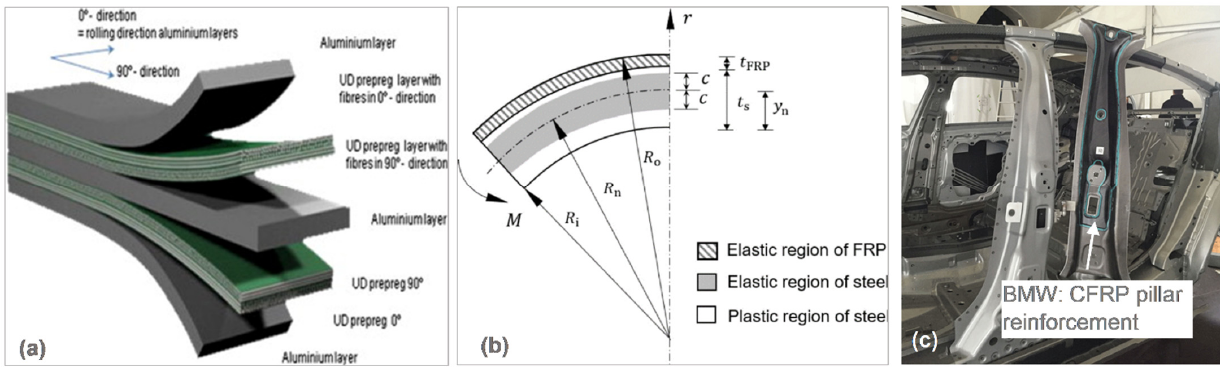
Figure 16. Application of fiber metal laminates in automotive parts: ( a ) general concept of FML [90]; ( b ) elastic and plastic regions of the steel–FRP composite under three-point bending [94]; and ( c ) 2016 BMW 7 Series (G12) CFRP B-pillar inner reinforcement [95].